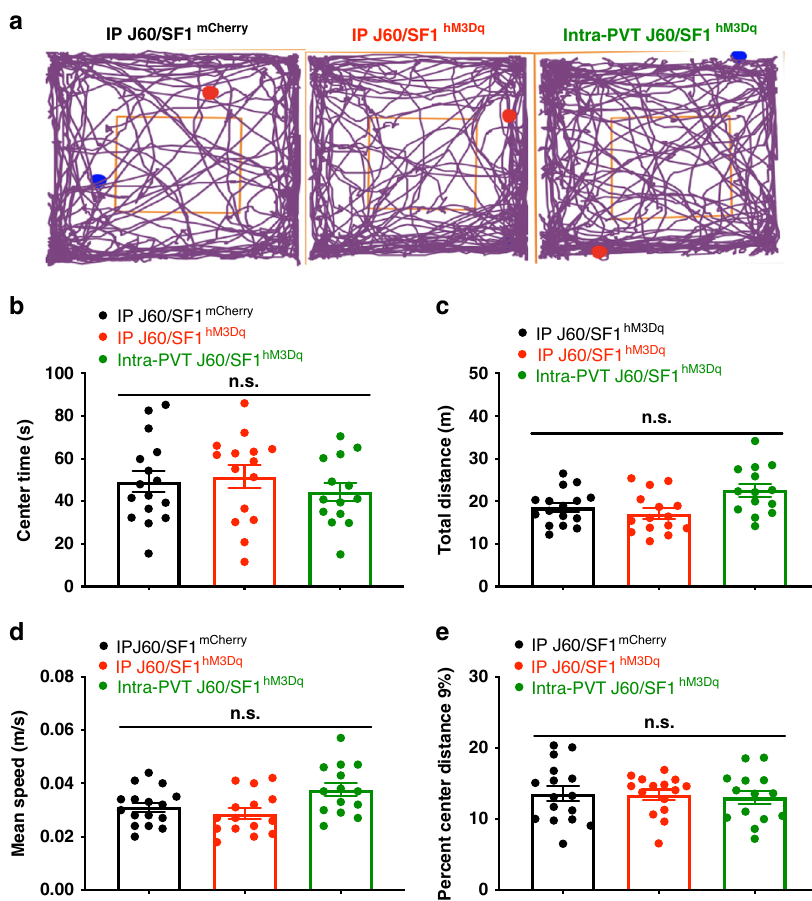
Fig. 7 No apparent effects of SF1 neurons or their projections to PVT on anxiety. Anxiety-related behavior in the open fi eld test was performed on mice transduced with hM3Dq or mCherry in the SF1 neurons. a Representative traces of open fi eld behavioral tests in mice treated with J60 via i.p. injections in mCherry and hM3Dq-transduced mice, or via intra-PVT injections. Group data of b time spent in the center of the open fi eld (mCherry ip J60 , n = 16; hM3Dq ipJ60 , n = 15; hM3Dq intra-PVTJ60 , n = 14). c Total distance traveled (mCherry ipJ60 , n = 16; hM3Dq ip J60 , n = 15; hM3Dq intra-PVT J60 , n = 14). d Mean speed (mCherry ip J60 , n = 16; hM3Dq ip J60 , n = 15; hM3Dq intra-PVT J60 , n = 14) and e percent center distance (mCherry ip J60 , n = 16; hM3Dq ip J60 , n = 15; hM3Dq intra-PVT J60 , n = 14). One-way ANOVA with Turkey post hoc tests; data represent mean ± s.e.m.; n.s. not signi fi